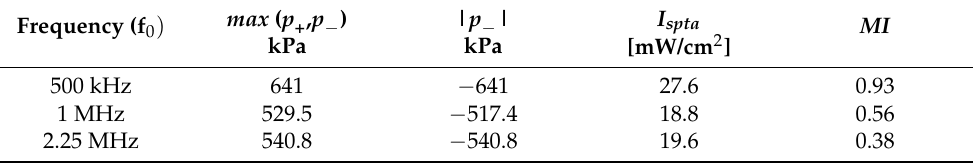
Table 5. The mean acoustical intensities and mechanical indexes at 500 kHz, 1 MHz, and 2.25